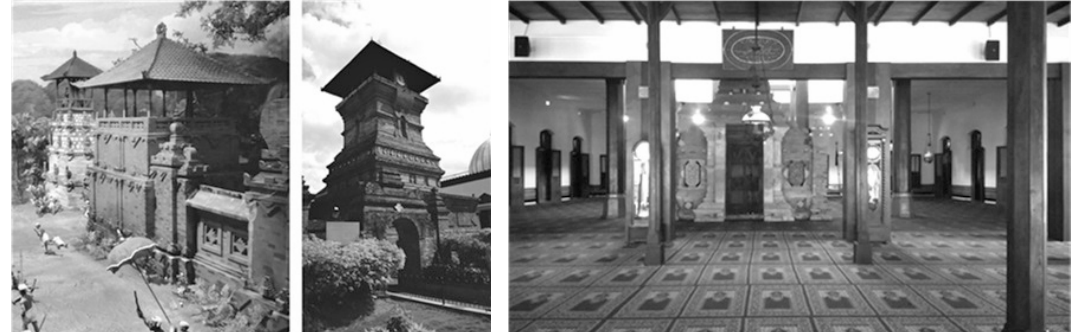
Figure 4. Bell tower of bale kulkul Bali (left), the drum tower of Kudus Menara Mosque (centre), and the temple gate in the mosque interior(right) (photos: author)